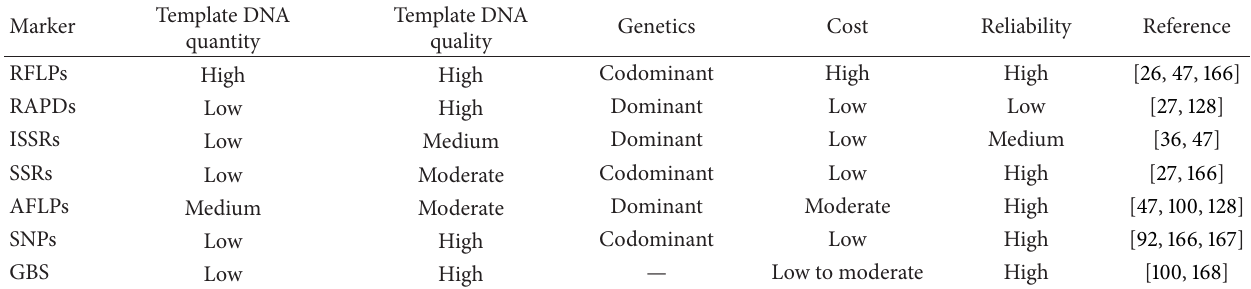
Table 1: Comparison of marker systems in